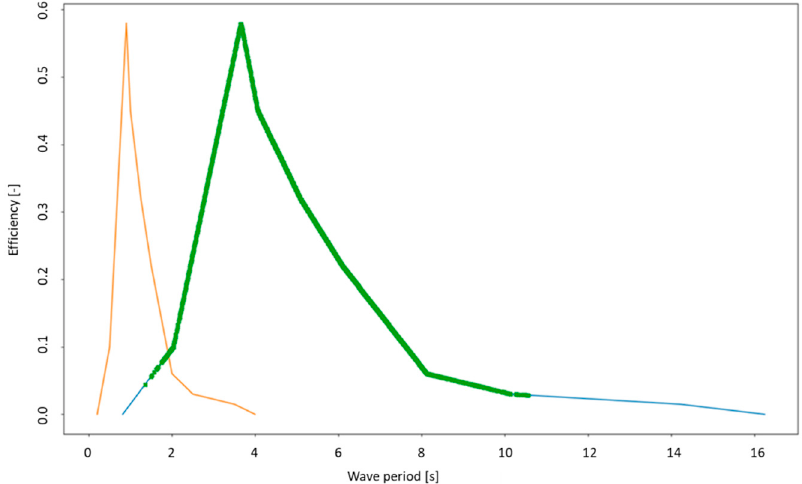
Figure 9. Efficiency of a Weptos with 3.96 m rotors diameter over different wave periods (green) and in the laboratory (yellow).